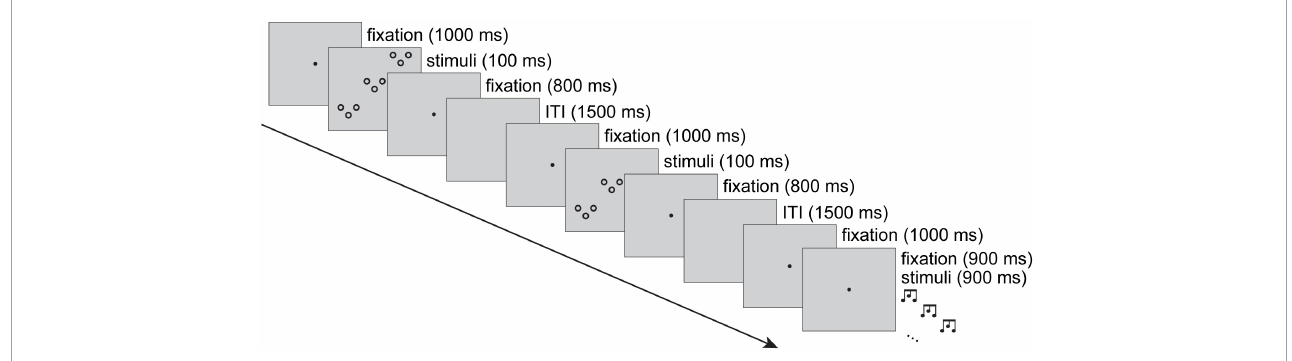
FIGURE2 The experimental procedure displayed with a sequence of three trials. Visual and auditory trials were intermixed, with 1.5-s inter-trial intervals (ITIs). In the figure, the first trial shows a visual rising-rising global pattern and falling-rising local pattern. The second trial shows a visual rising-falling global pattern and a falling-rising local pattern. The third trial shows an auditory falling-falling global pattern and a rising-falling local pattern (while a simultaneous visual fixation is on the screen). Trials were coded according to modality, modality priming, target priming, level, and level priming. Thus, for a participant assigned falling-rising and falling-falling target patterns, in the examples depicted, accurate responses would be falling-rising, falling-rising and falling-falling. The second trial (subject to priming from the first) would contribute to the visual, within-modality, same-target, local, same-level condition, and the third trial (subject to priming from the second) would contribute to the auditory, across-modality, different-target, global, different-level